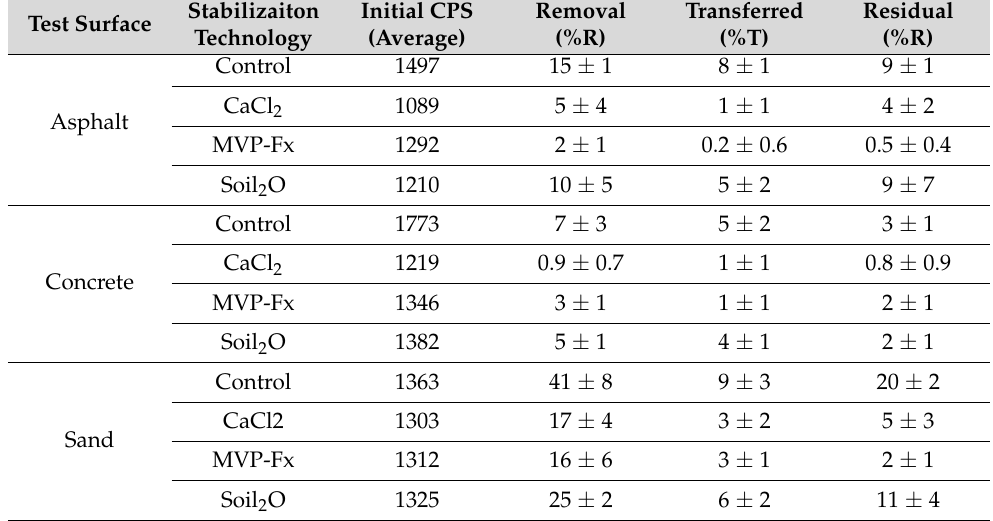
Table 3. Efficacy of stabilization technologies during simulated vehicle experiments, expressed as average ± standard